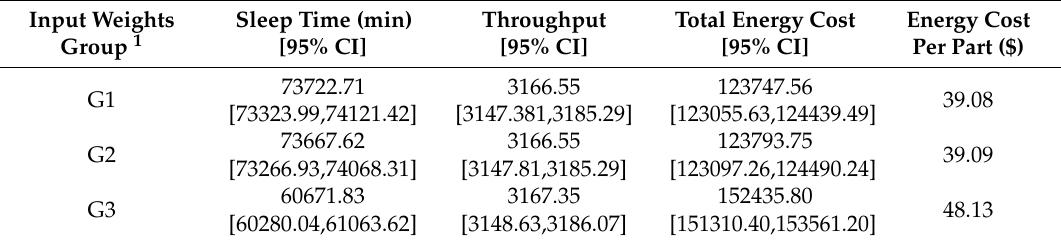
Table 9. System performance comparison of input weights group in